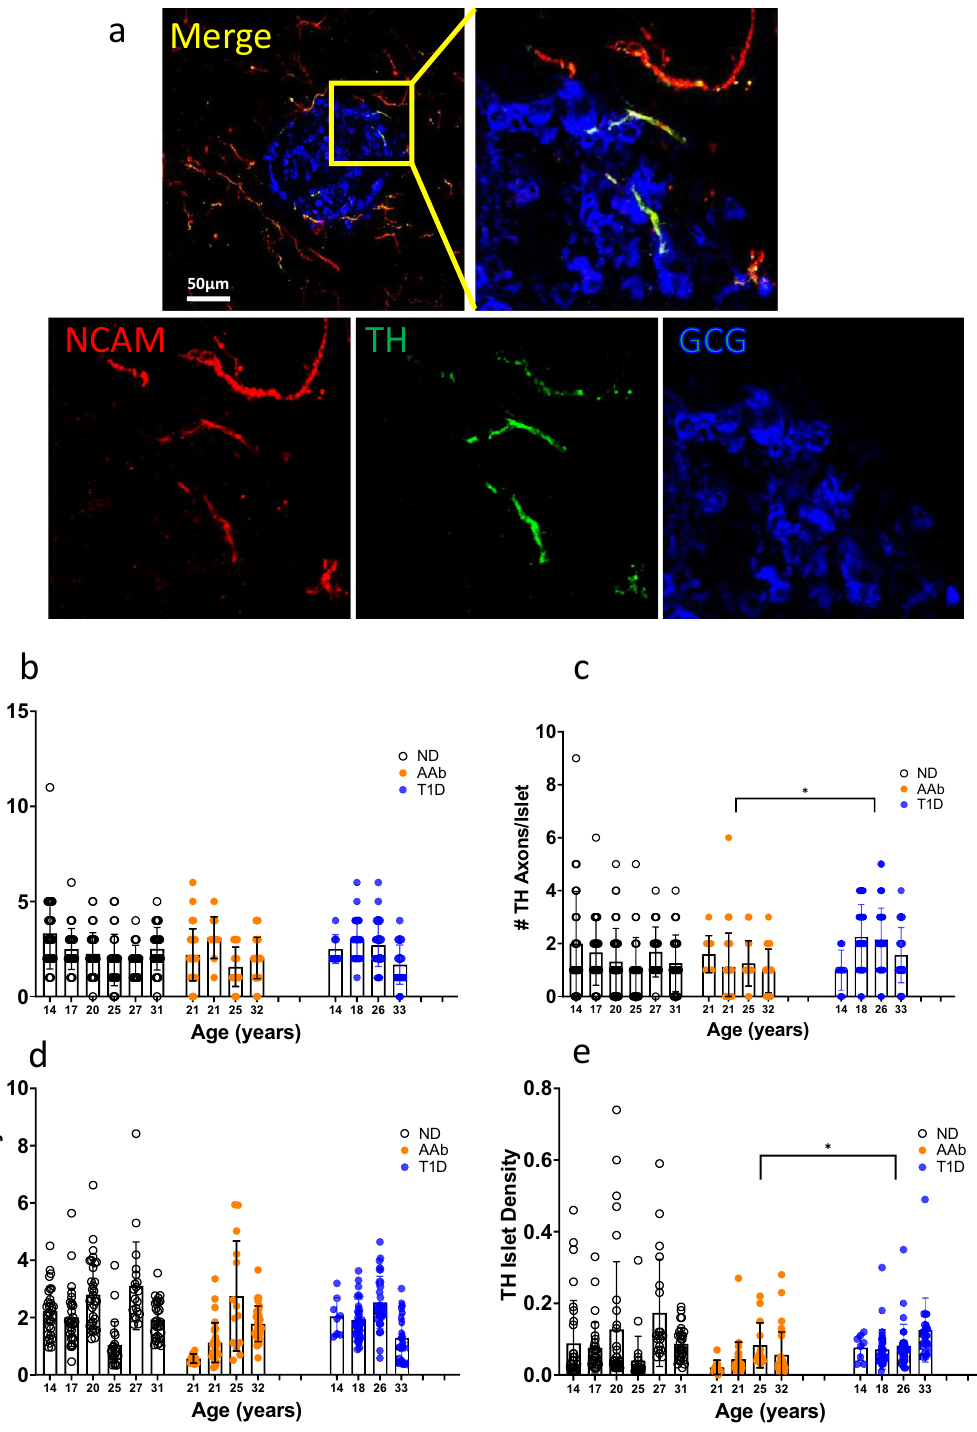
Figure 3. Islet NCAM and TH axon counts and morphometry in T1D. ( a ) Maximum intensity projection of a confocal islet image from a control donor stained by NCAM (red), TH (green), and glucagon (GCG, blue) in a fixed frozen section. A merged image (left upper) with boxed inset for higher detail of intra-islet axons. Single channel images for NCAM and TH show TH axons traveling with NCAM axons into an islet. Scale bar 50 µm. ( b ) NCAM axons per islet were counted (n = 185 islets in 6 ND donors, n = 93 islets in 4 AAb donors, n = 118 islets in 4 T1D donors). ( c ) TH axons per islet were counted (n = 185 islets in 6 ND donors, n = 93 islets in 4 AAb donors, n = 118 islets in 4 T1D donors). *p = 0.05 AAb vs. T1D. ( d ) NCAM axon density within islets was analyzed using ImageJ (n = 167 islets in 6 ND donors, n = 85 islets in 4 AAb donors, n = 93 islets in 4 T1D donors). ( e ) TH axon density within islets was analyzed using ImageJ (n = 167 islets in 6 ND donors, n = 85 islets in 4 AAb donors, n = 93 islets in 4 T1D donors). *p = 0.05 AAb vs. T1D. Data are presented as mean ± SD per donor. All statistical significance values were determined using nested 1-way ANOVA with multiple comparisons. See also Supplementary Fig.